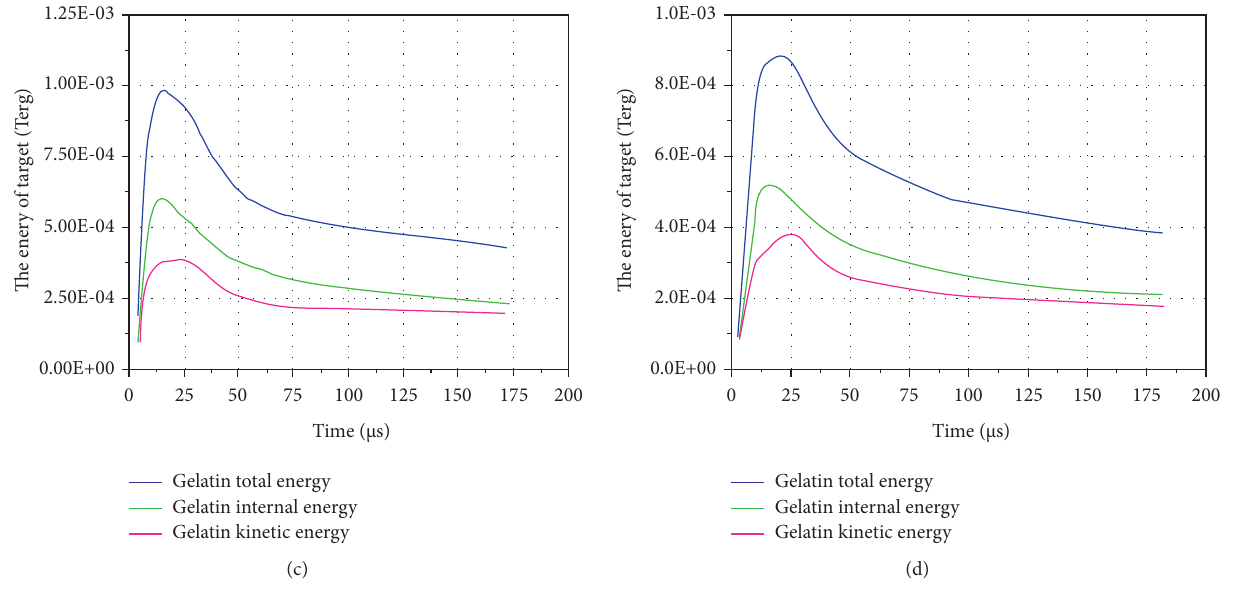
Figure 11: Energy absorption curve of gelatin target during micro-jet penetration: (a) copper jet; (b) Teflon jet, (c) nylon jet; and (d) polycarb jet. Table 4: Stress and strain distributions of gelatin target at the end of penetration by different